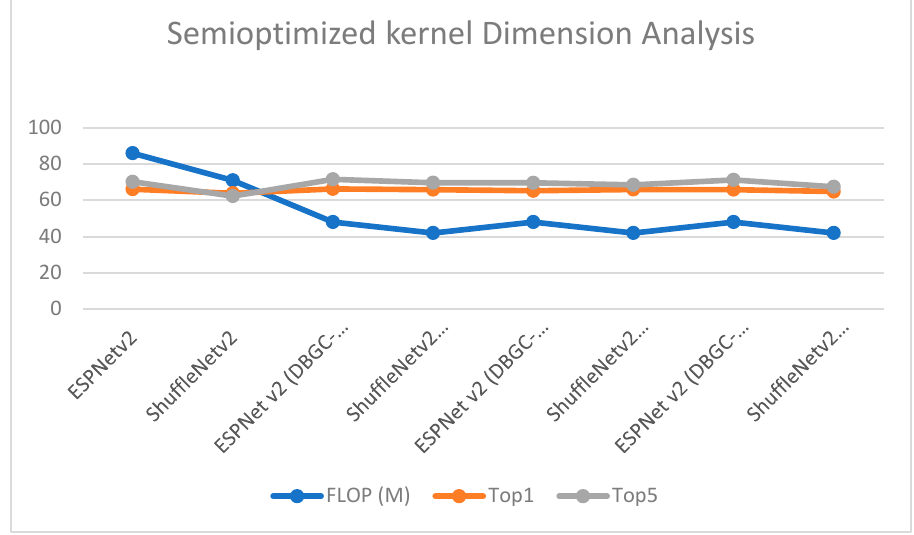
Figure 22. Semi-optimized kernel dimension.